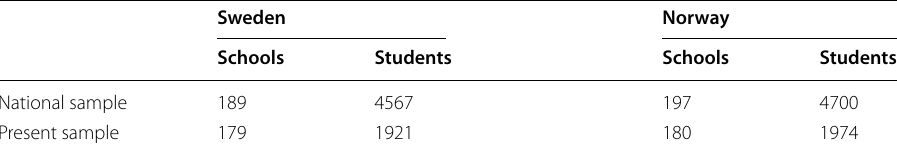
Table 1 Total national PISA samples and samples in the present study by country, schools, and students